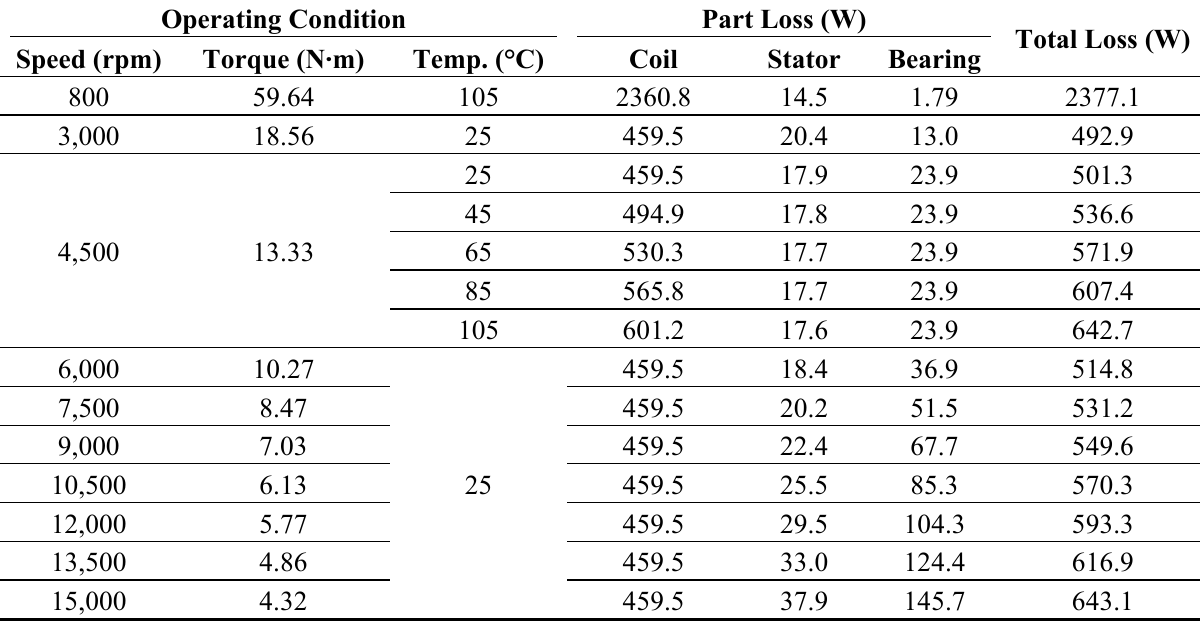
Table 4. Heat source variations with respect to the design and operating parameters.